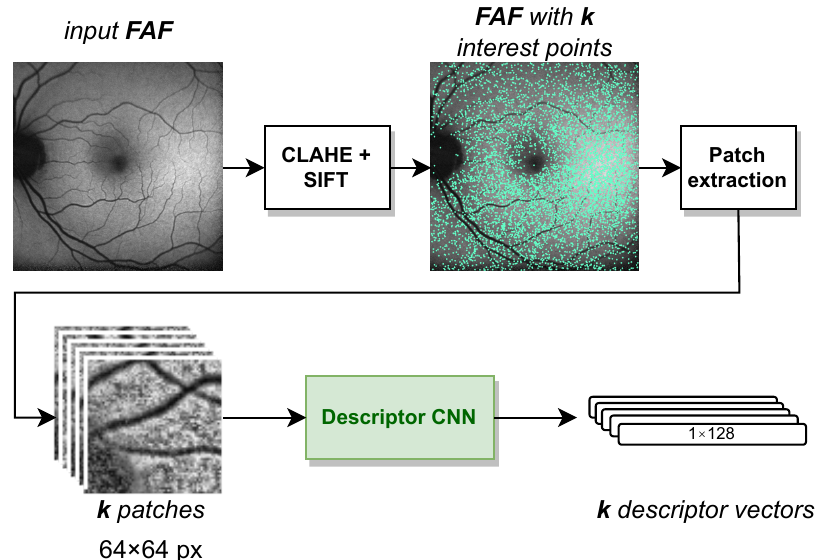
Figure 4. The steps inside the MedRegNet descriptor module [8]. Image contrast was improved with CLAHE [41]. Processing is identical for IR images.